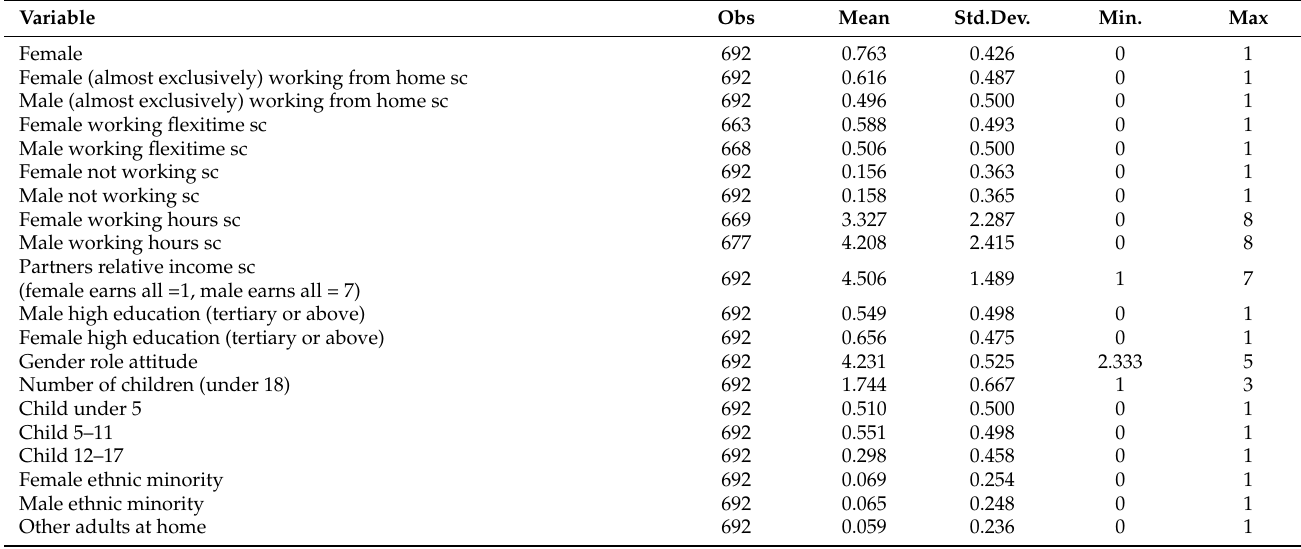
Table A1. Descriptive tables for all independent variables (sc = since COVID, bc = before